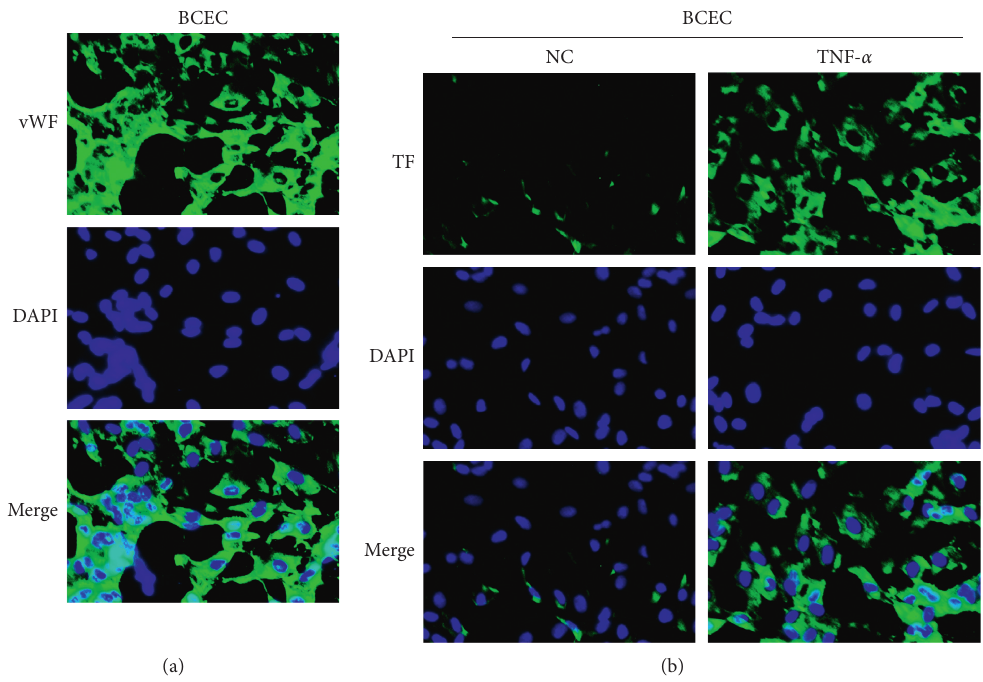
Figure 2: BCEC/TF model construction and identification. (a) The vWF expression level. (b) The TF expression level (data are shown by mean ± SD, N � 3).